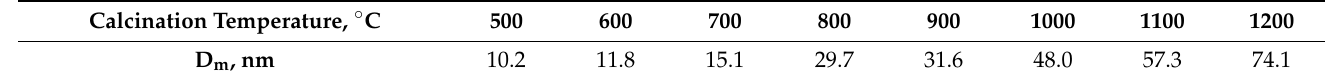
Table 2. The grain size from XRD for MgFe 2 O 4 samples calcined at different